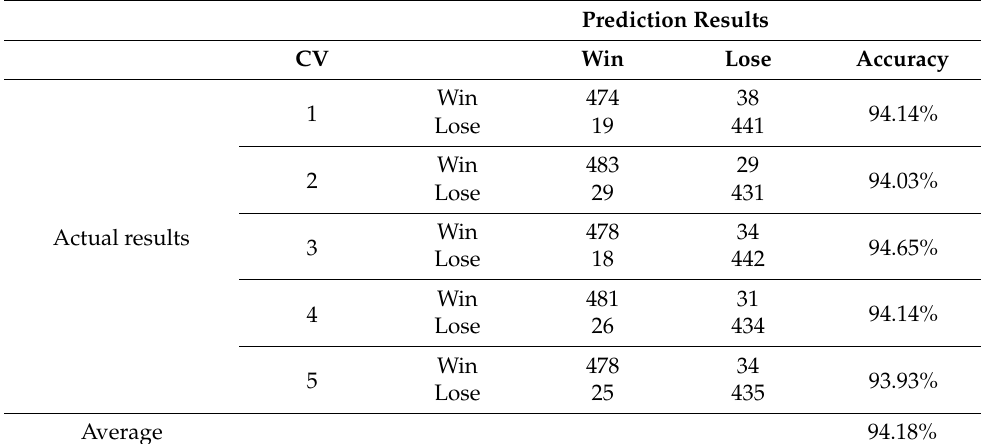
Table 14. Confusion matrix of ANN after feature selection (dataset 2).